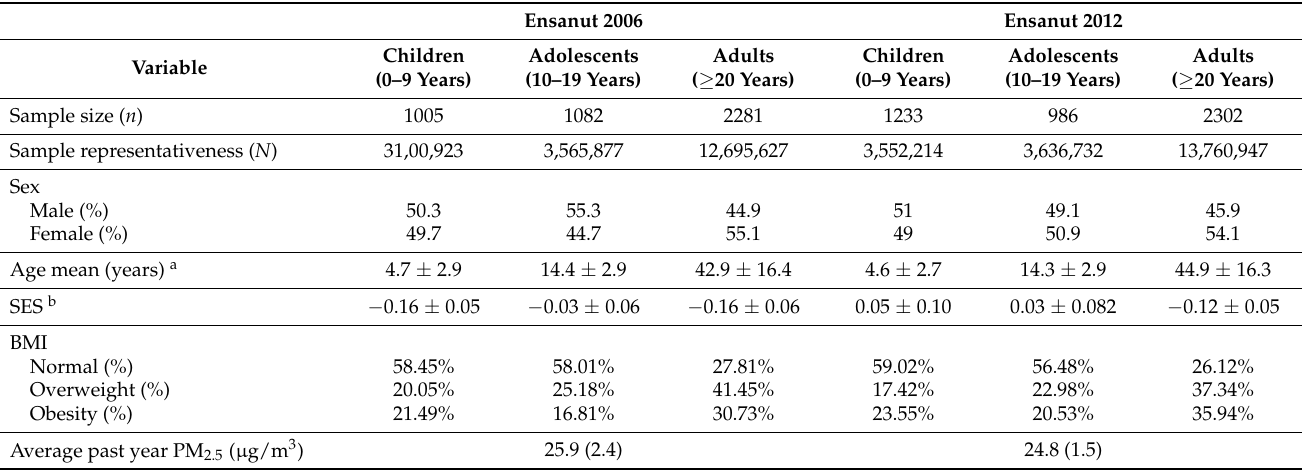
Table 1. Descriptive statistics in population samples for Mexican National Survey of Health and Nutrition (ENSANUT) 2006 and 2012 from the Greater Mexico City Area.